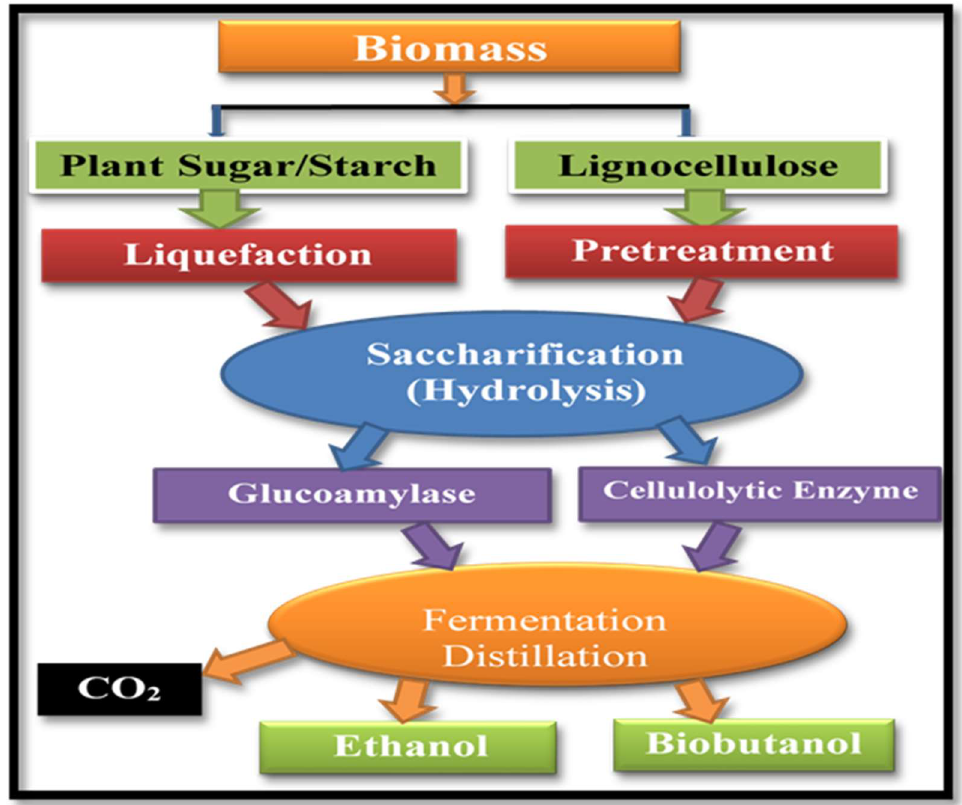
Figure 2. Biochemical conversion of biomass to alcohol fuels (modified from Ref. [30]).